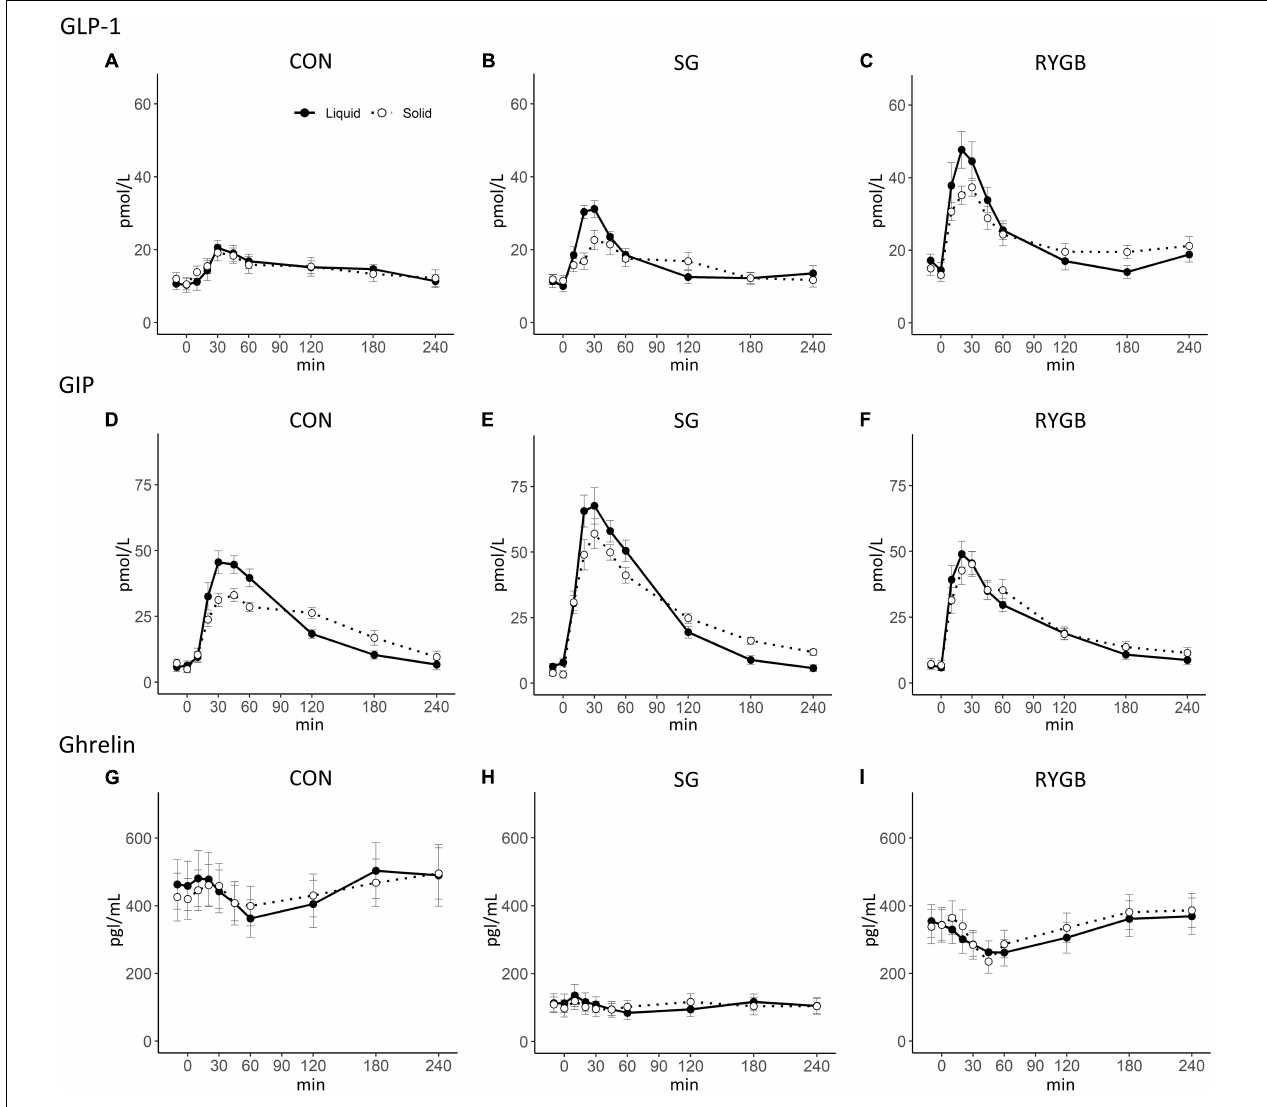
FIGURE 2 | Plasma concentrations of total GLP-1, total GIP, and total ghrelin on two different study days with either a liquid or a solid meal. (A–C) total GLP-1; (D–F) total GIP; (G–I) total ghrelin. Data are mean ± SEM. Black (solid line), liquid; white (dotted line),